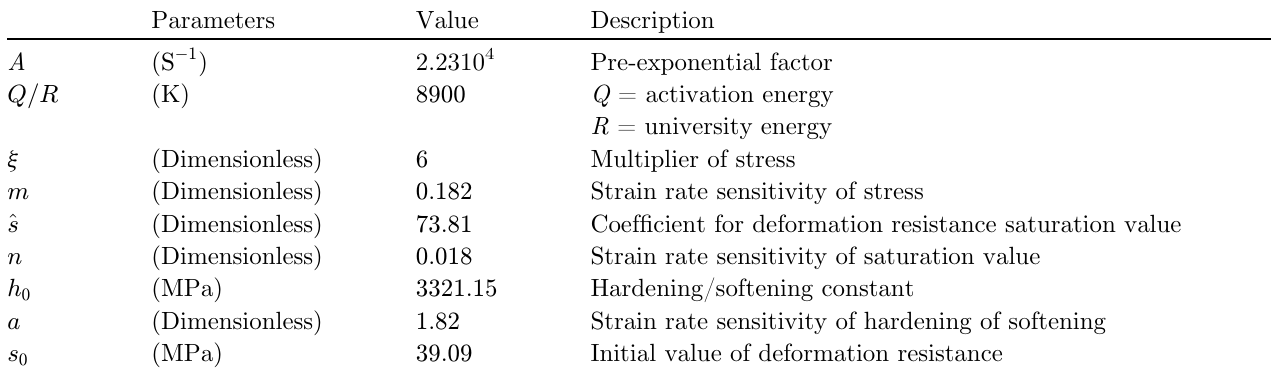
Table 2. Parameters of Anand model [10].